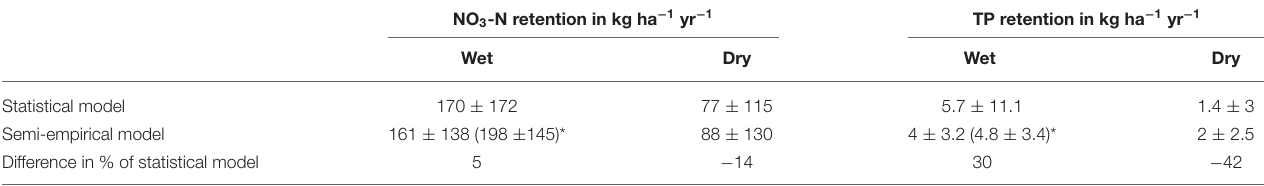
TABLE 2 | Resulting nutrient retention calculated by the semi-empirical and statistical models for three hydraulic conditions in the study